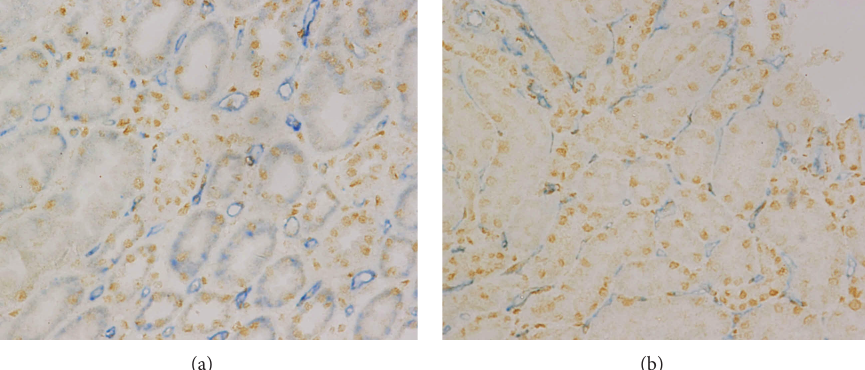
Figure 4: HIF-1 𝛼 expression in antibody-mediated rejection (ABMR) and T cell-mediated rejection (TCMR). Double staining of CD31 and HIF-1 𝛼 showed capillary dilation, and HIF-1 𝛼 expression occurred somewhat in parallel both in ABMR (a) and TCMR (b) while HIF-1 𝛼 expression was not necessary for capillary dilation. Original magnification, × 400.